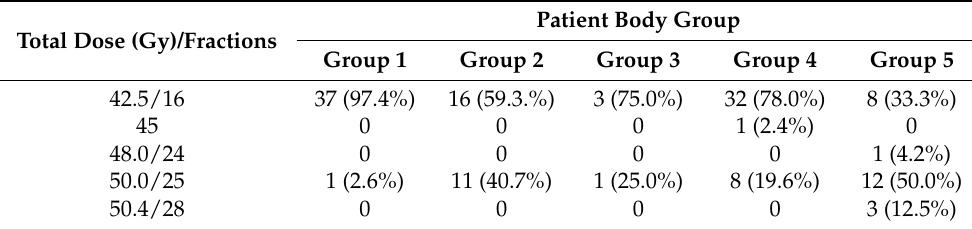
Table 2. Prescribed dose as a function of patient body group (criteria shown in Table 1). Total Dose